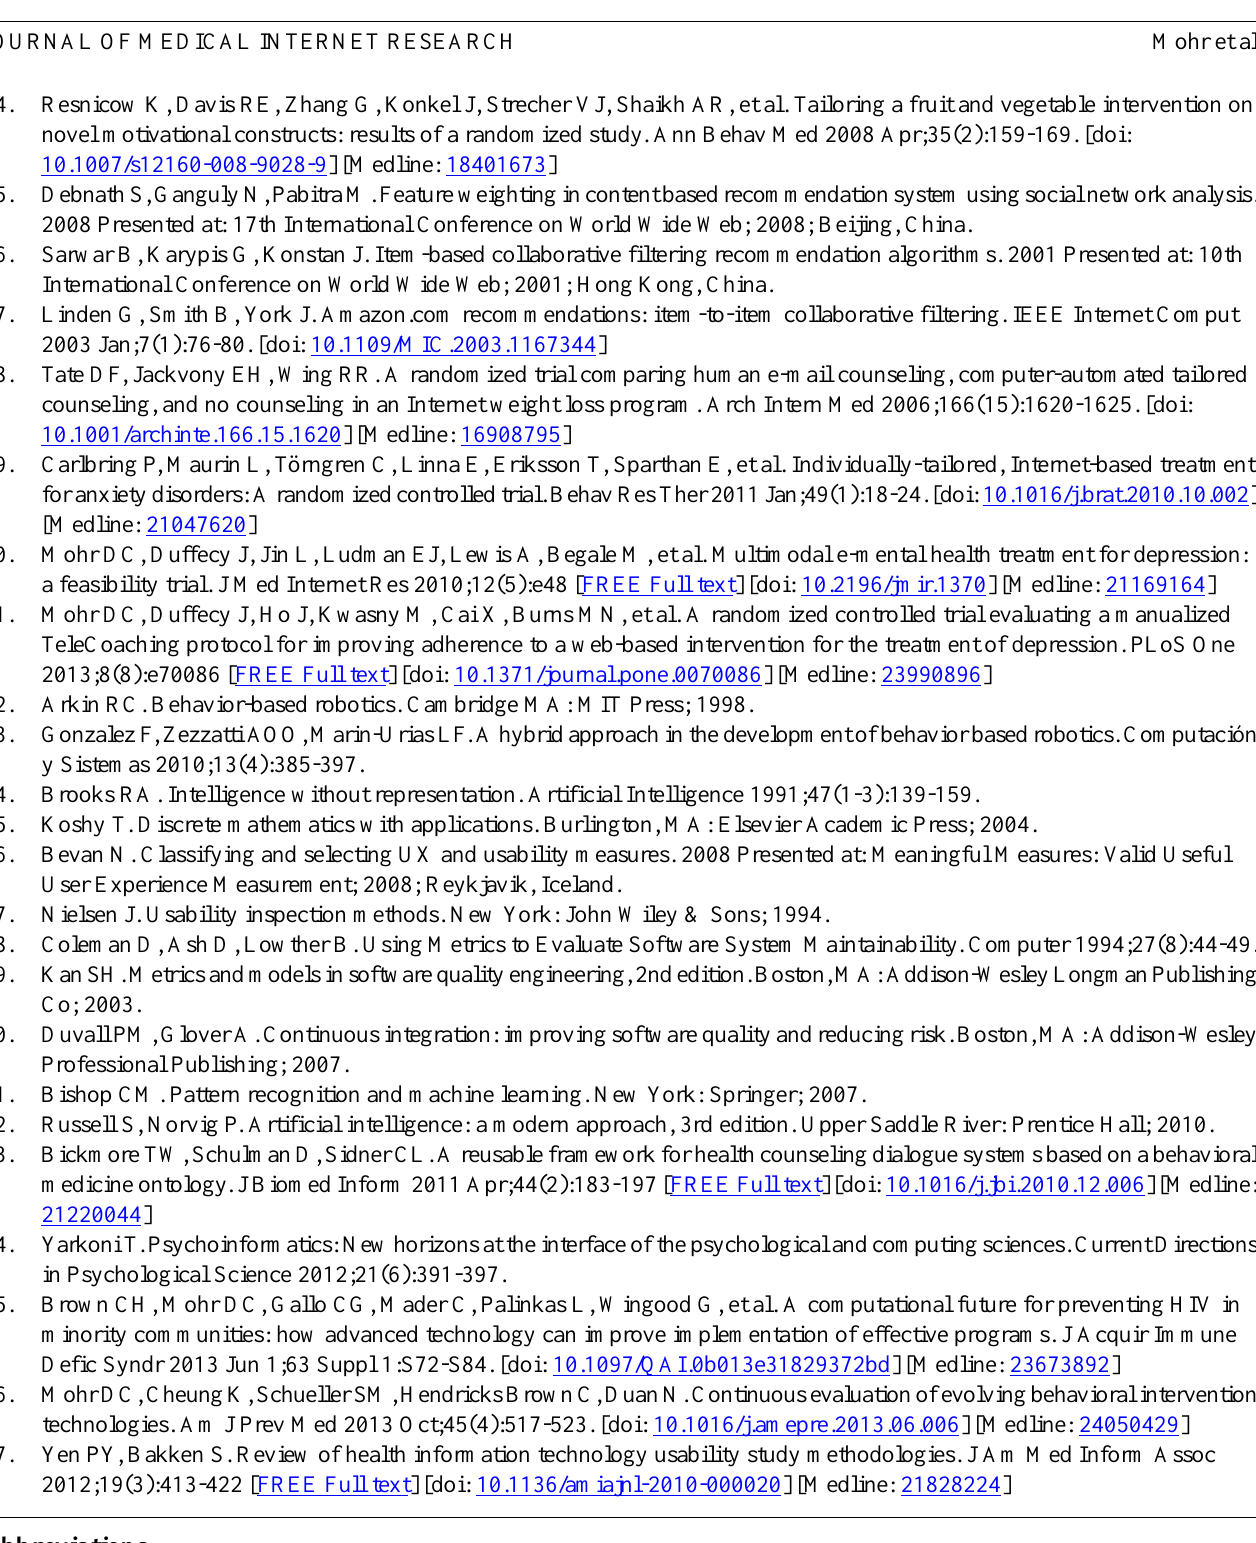
BIT: behavioral intervention technology BIT-Tech: Behavioral Intervention Technology—Technological Instantiation FSM: finite state